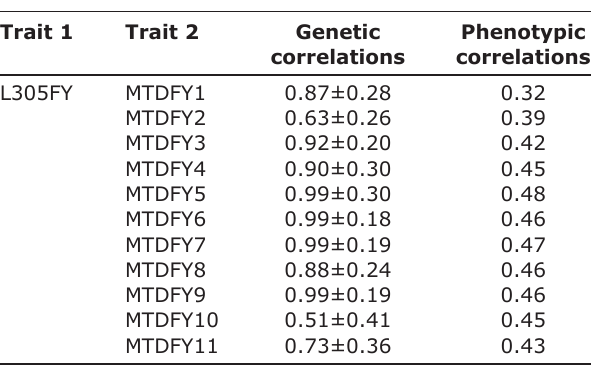
Table-4: Genetic and phenotypic correlations among L305FY and different MTDFY. Trait 1 Trait 2 Genetic